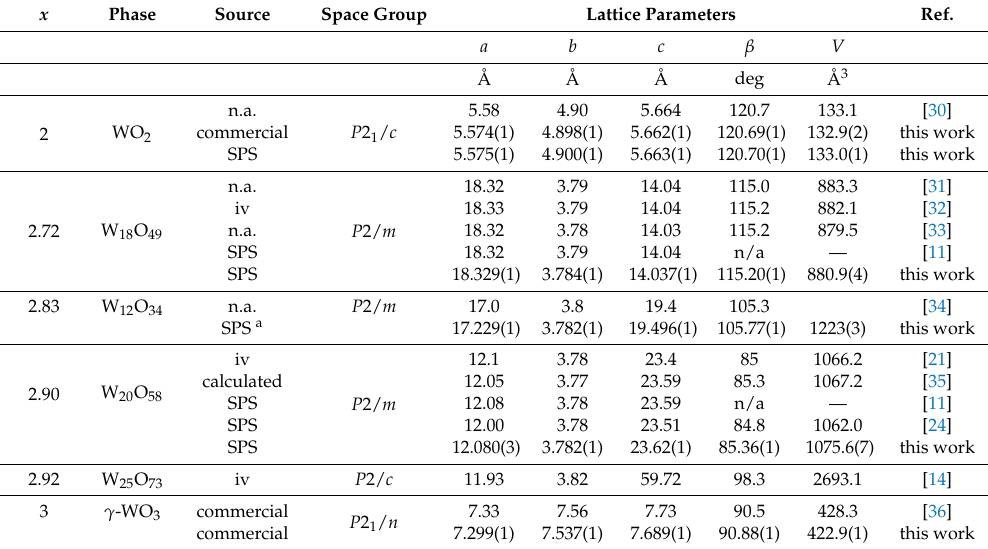
Table 1. Lattice parameters of phases in the tungsten–oxygen binary system refined from PXRD patterns in this work in comparison to literature data (iv—long-term heating in vacuo, SPS—spark plasma sintering, n.a.—not specified in the